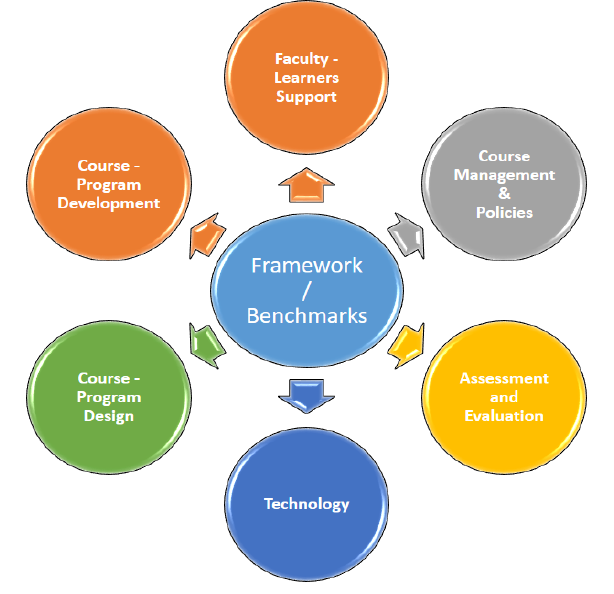
Figure 1. Quality indicators for digital